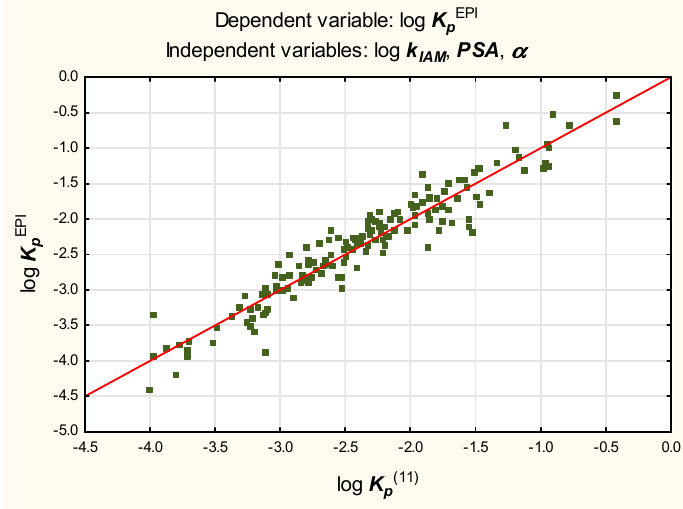
Figure 2. Equation (11)—reference vs. predicted log K p values.